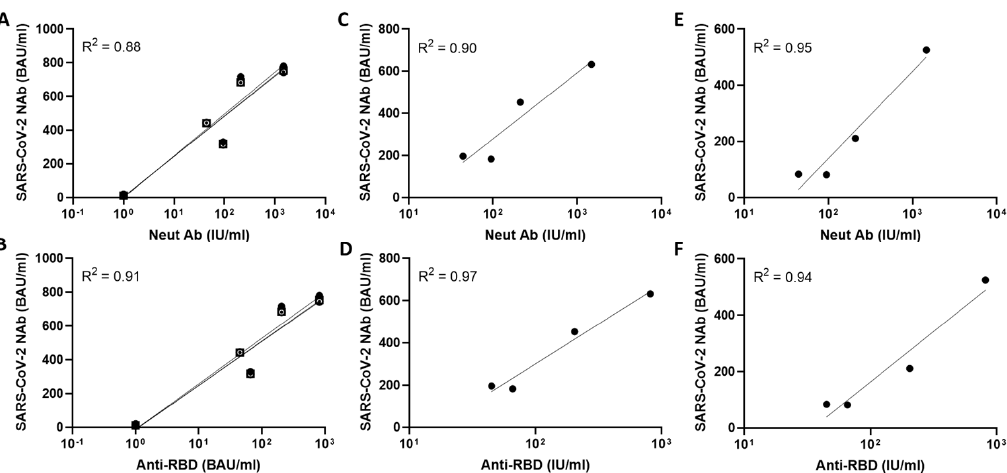
Figure 3. Correlations of levels of NIBSC standards NAb to SARS-CoV-2 by TRFIA with WHO data Neut Ab ( A , C , E ) and Anti-RBD ( B , D , F ). ( A , B ) represent undiluted NIBSC standards; ( C , D ) repre- sent 1:10 dilution of NIBSC standards; and ( E , F ) represent 1:100 dilution of NIBSC standards. Cor- relations by linear regression are shown as R 2 values. Data are shown as the average of 3 independ- ent analyses.